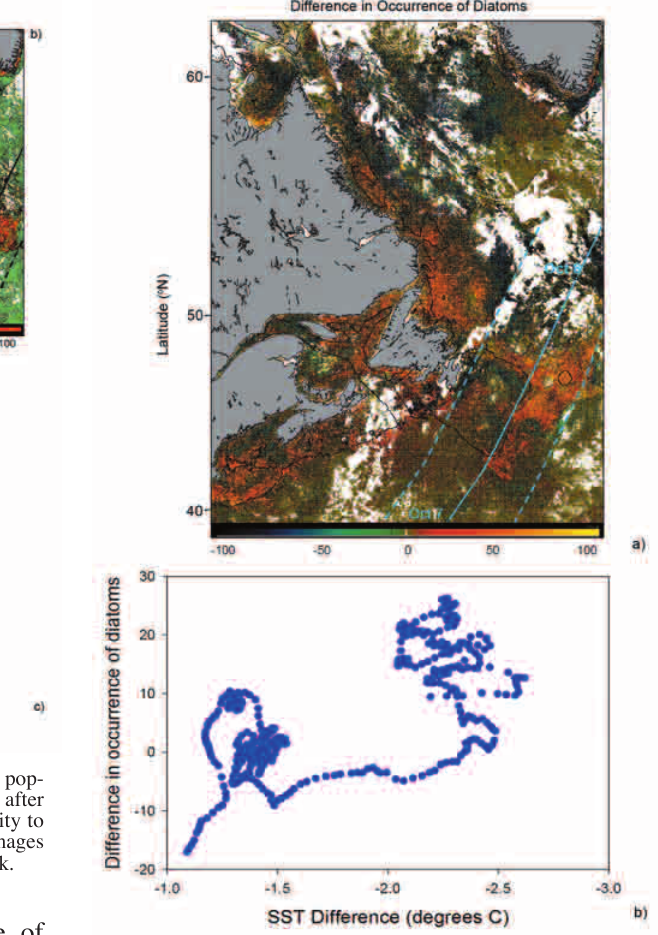
Fig. 15. – Differences (composite after - composite before) in the probability to find diatom-dominated populations (a). Red to yellow (positive values) colour denote increased probabilities. Green to blue colours (negative values) show decreased probabilities. Scatter plot of differences of SST against differences of probability to find diatoms dominance (b). The data are extracted from the composite images under the 700 km area, and averaged across the storm track. The low (or high) values of change are related with the left (or right) side of the storm